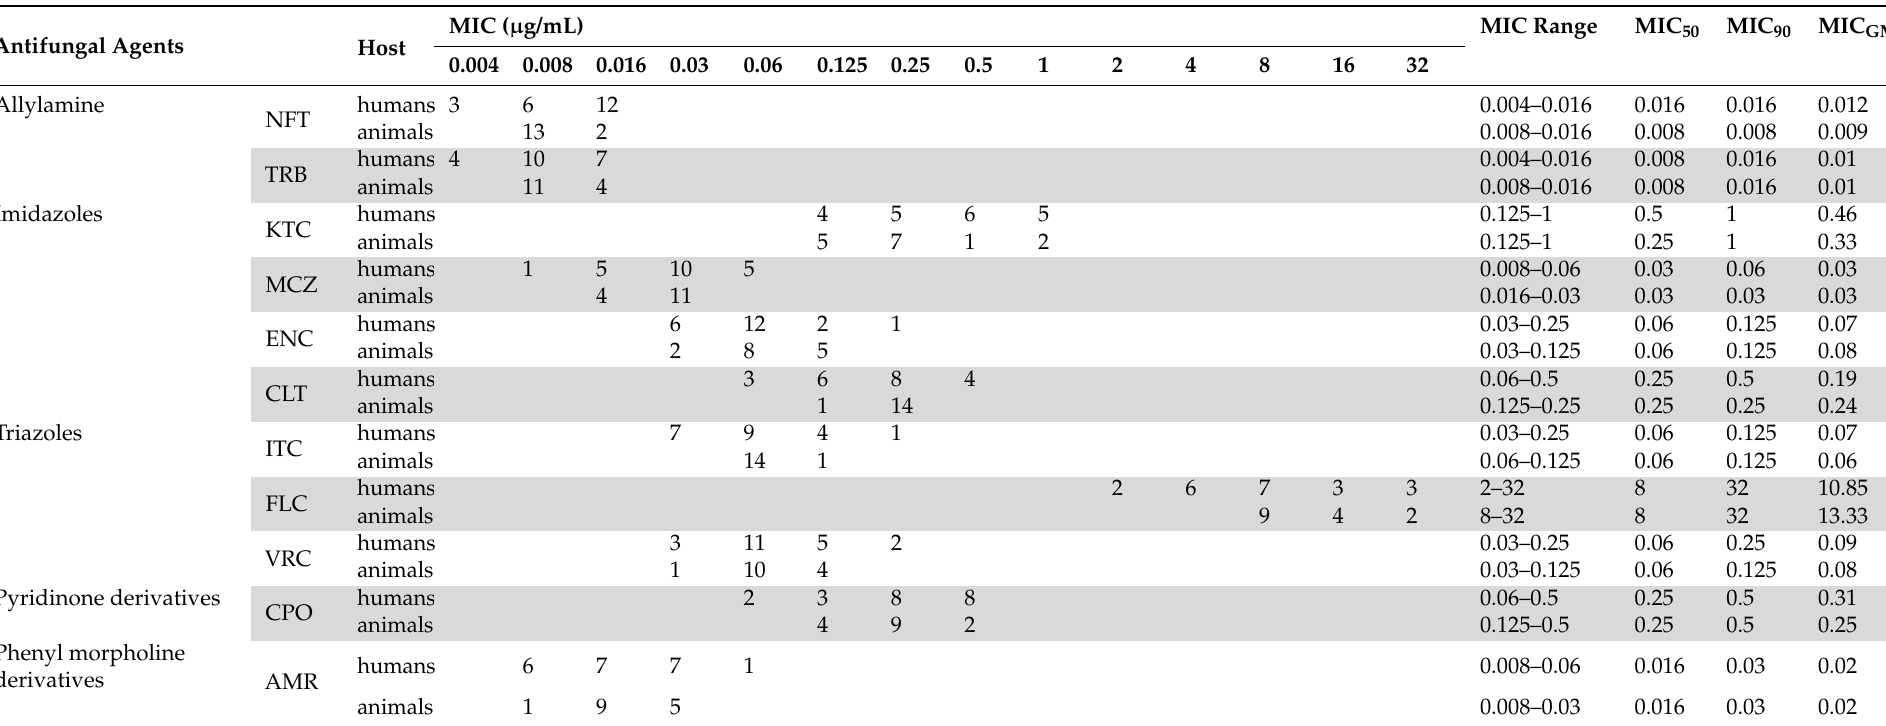
Table 2. In vitro antifungal susceptibilities of clinical isolates of Trichophyton quinckeanum obtained from humans and